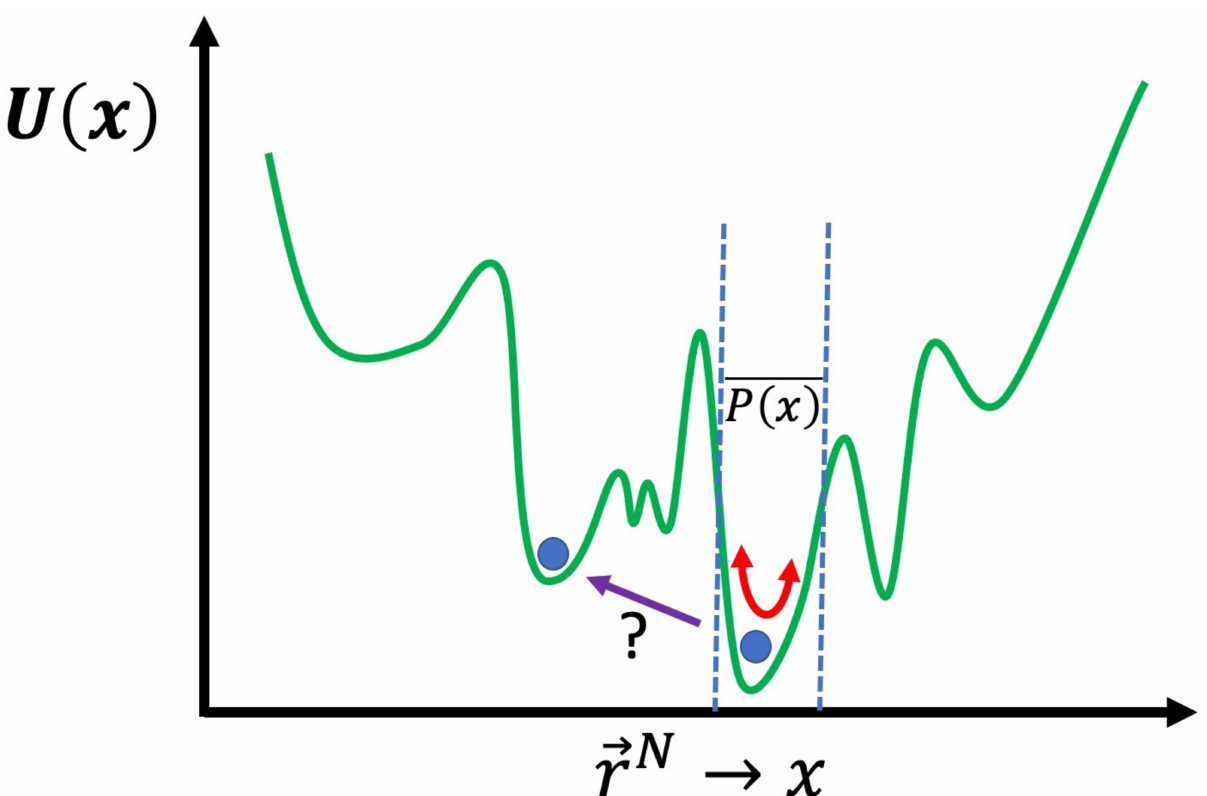
Figure 2. Schematic of the energy landscape of a system; with basic unbiased MD or MC simulation, if performed below a certain temperature, only the region of the local minimum will be explored, thus a result for P ( here. Finding the free energy change to another region of conformation space, where the energy barrier must be crossed and N → P ( r , T ) determined along the path, is not practically possible without the advanced biasing schemes we